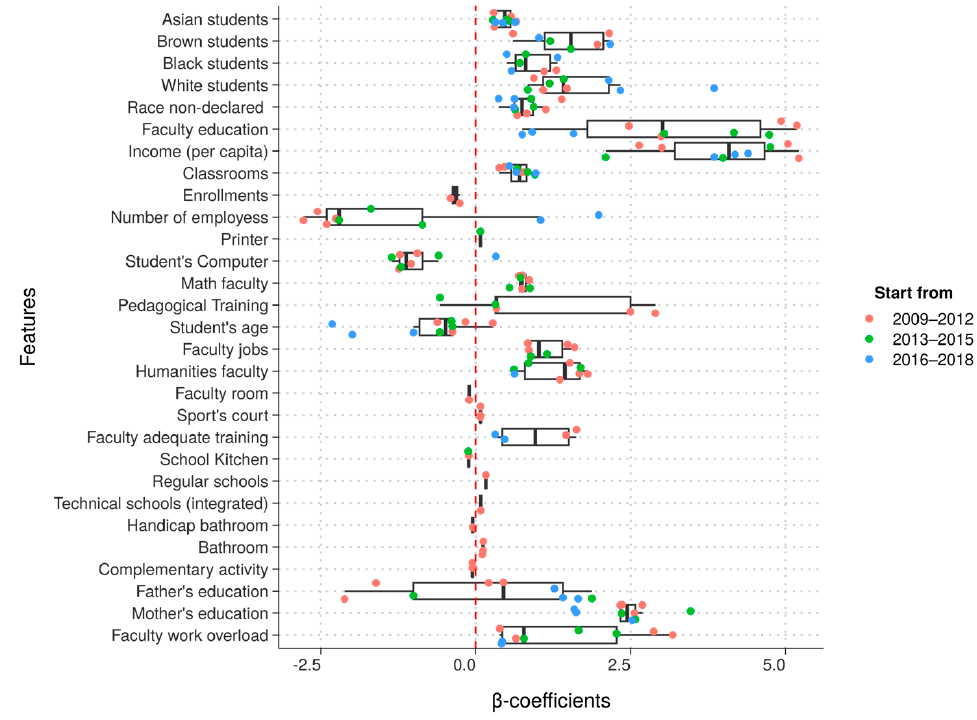
Figure 3. Significant coefficients ( p -value < 0.05) for all periods. Figure 3. Signi fi cant coe ffi cients ( p -value < 0.05) for all periods.